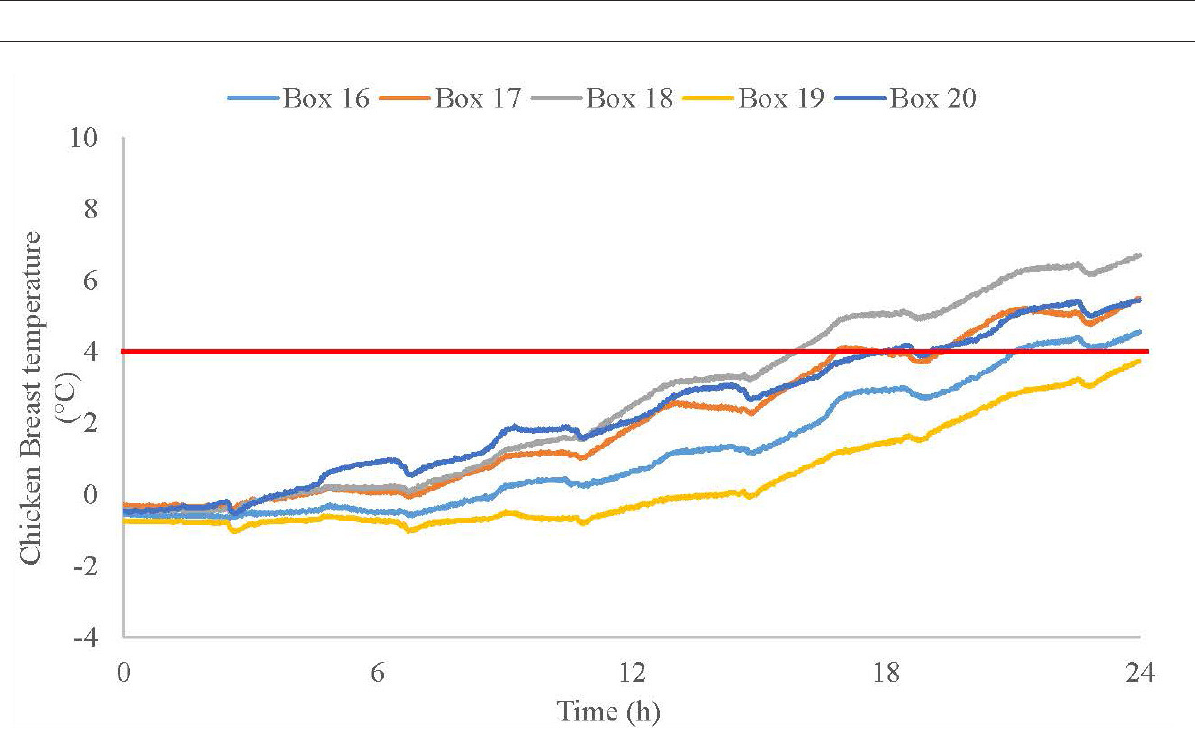
FIGURE5 Averaged temperature profiles (4 replications) of bottom layer (layer 4) boxes of palletized chicken breasts while experiencing simulated LTL cyclic TA (2h at 4 ◦ C then 2h at 25 ◦ C).